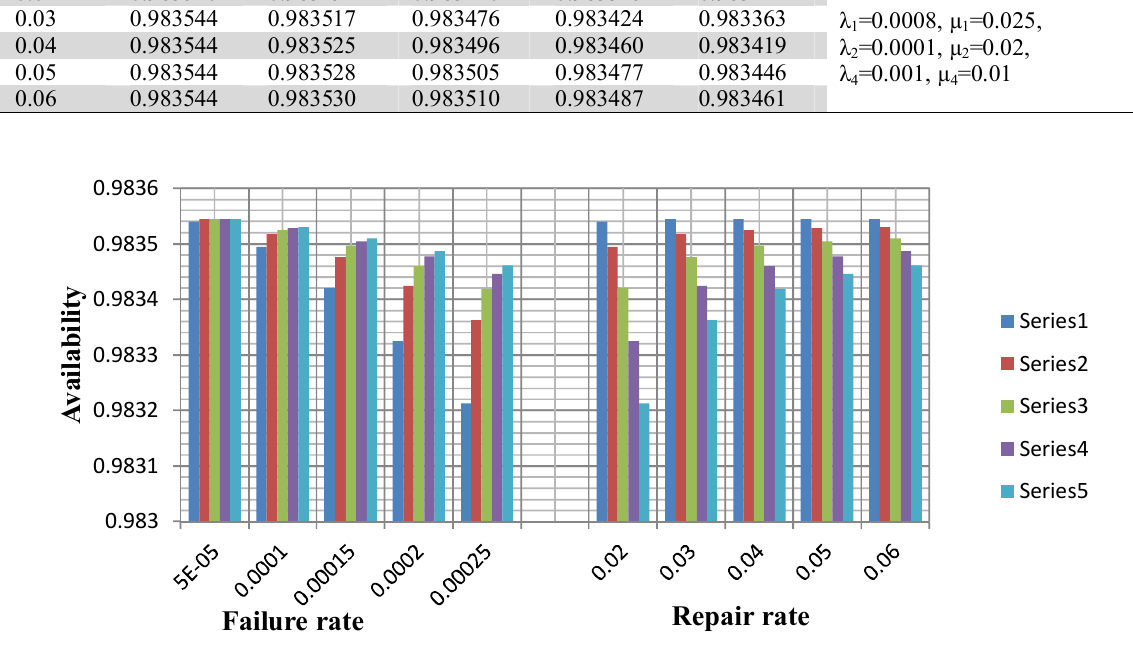
Fig. 4 : Effect of Failure and Repair Rates of Forced Draft Fan on Availability (A